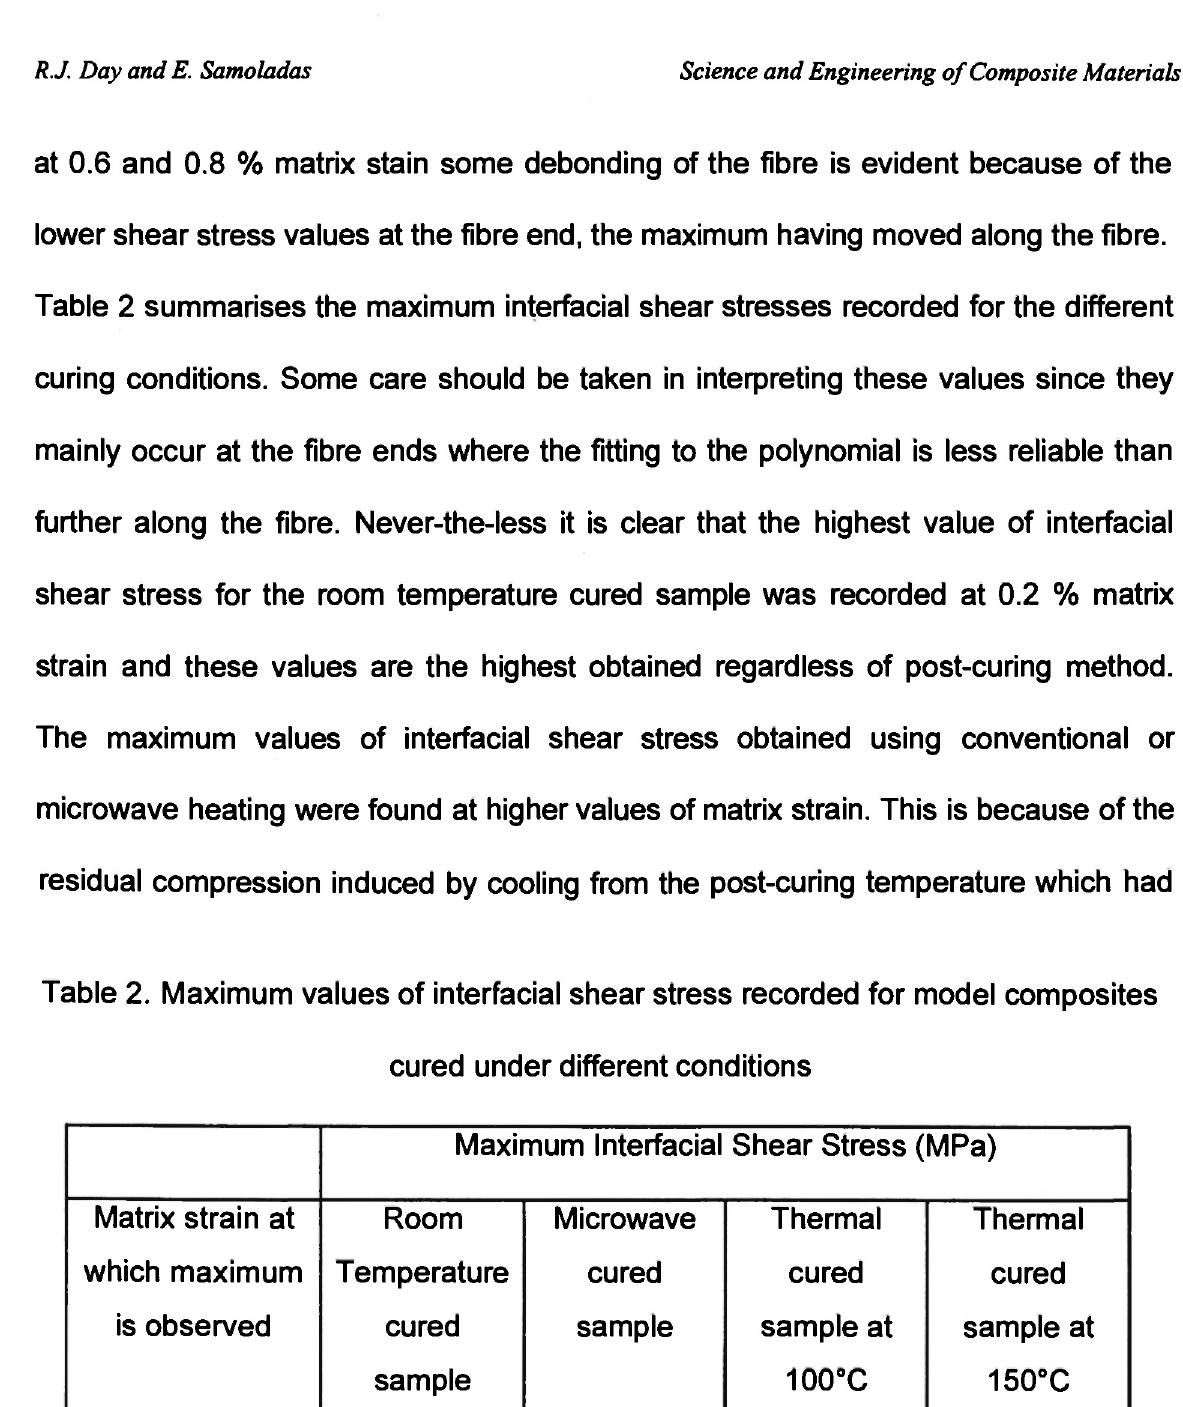
Table 2. Maximum values of interfacial shear stress recorded for model